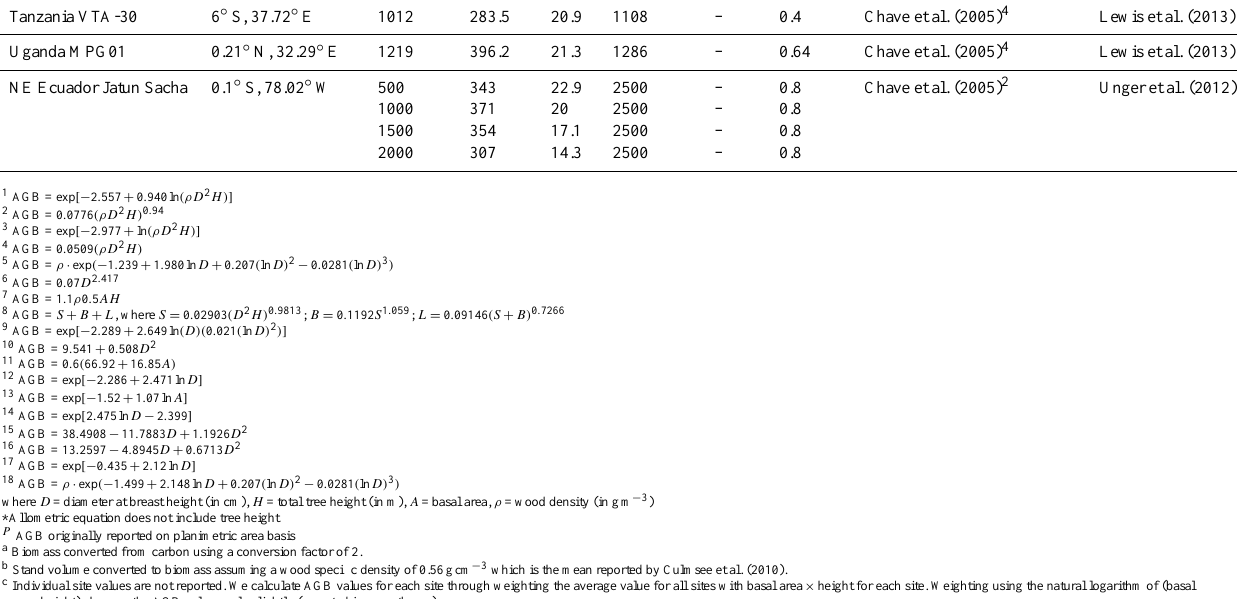
*Allometricequationdoesnotincludetreeheight P AGBoriginallyreportedonplanimetricareabasis a Biomassconvertedfromcarbonusingaconversionfactorof2. b Standvolumeconvertedtobiomassassumingawoodspecificdensityof0.56 gcm − 3 whichisthemeanreportedbyCulmseeetal.(2010). c Individualsitevaluesarenotreported.WecalculateAGBvaluesforeachsitethroughweightingtheaveragevalueforallsiteswithbasalarea ×